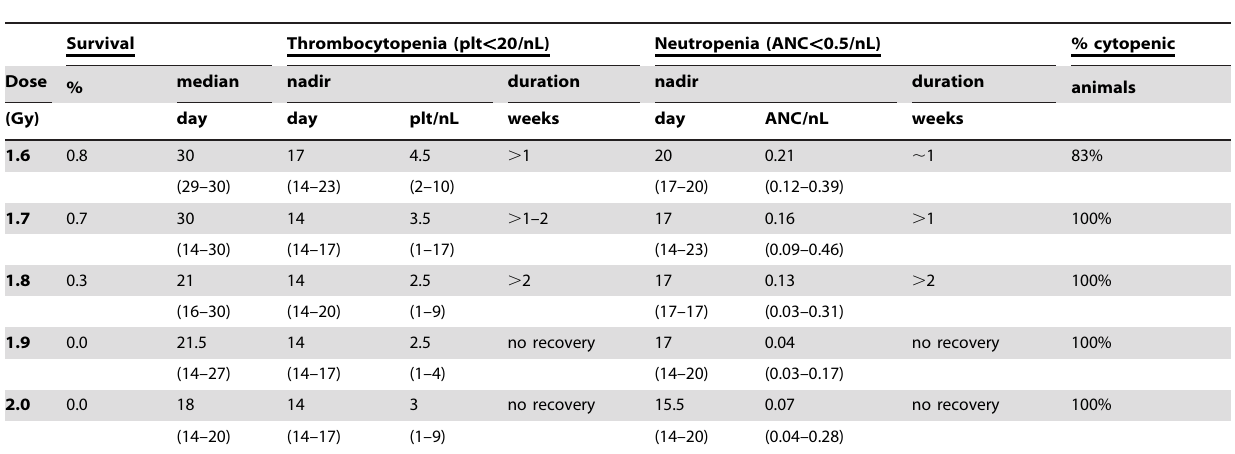
Table 1. Platelet and neutrophil nadirs and duration of cytopenias of irradiated minipigs.